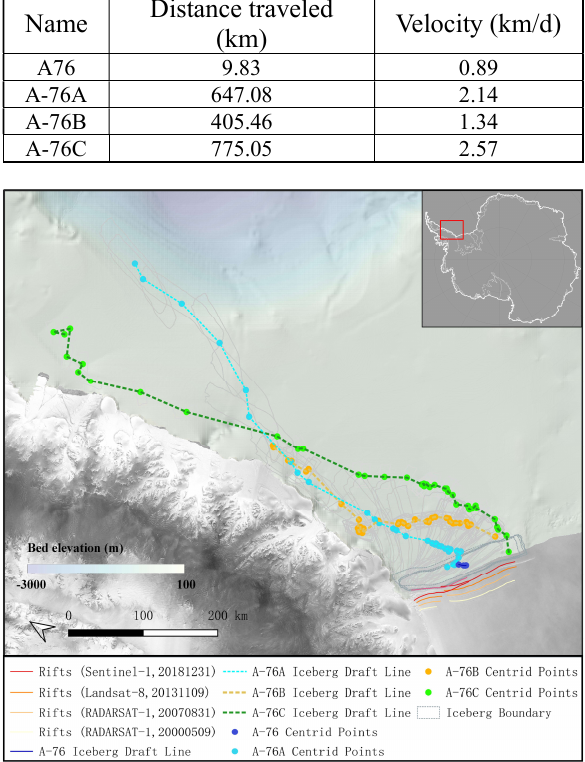
Figure 8. The motion trajectories of three icebergs from May 13, 2021 to March 11, 2022. The A-76, A-76A, A-76B, and A-76C icebergs trajectories overlaid with bed elevation data from BedMachine Antarctica (Morlighem et al.,